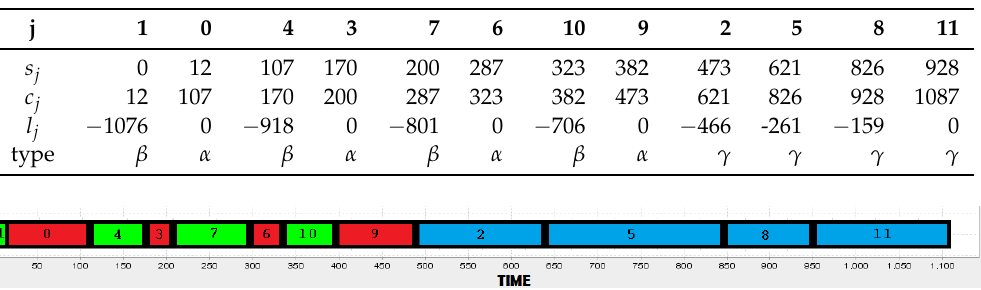
Table 11. Optimal solution for instance E_1_12.